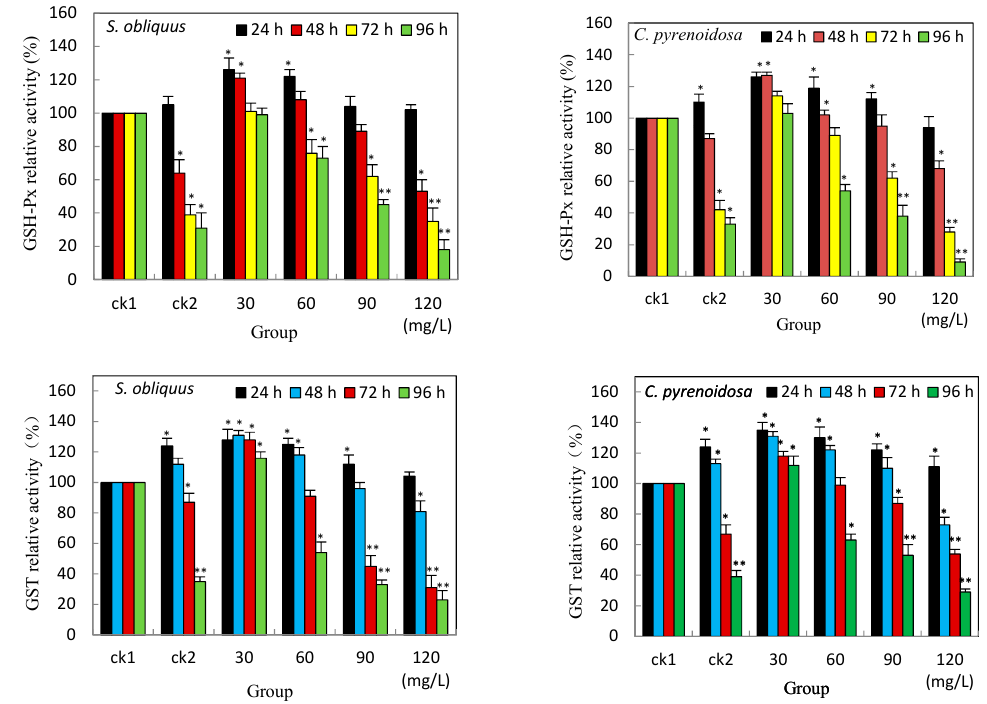
Figure 3. Effects of salicylic acid on the GSH-Px and GST activities of S. obliquus and C. pyrenoidosa under Cd 2+ stress. Note: * means there is statistical significance compared with the ck1 group at the same period, p < 0.05; ** means compared with the ck1 group at the same period, p <